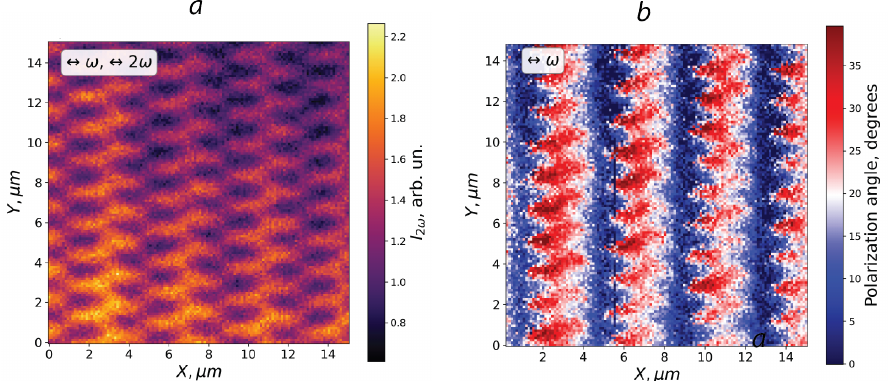
Figure 5. ( a ) SHG microscopy image of the garnet film measured for the parallel polarizations of the fundamental beam and SHG that are perpendicular to the domains; ( b ) SHG polarization-plane rotation spatial